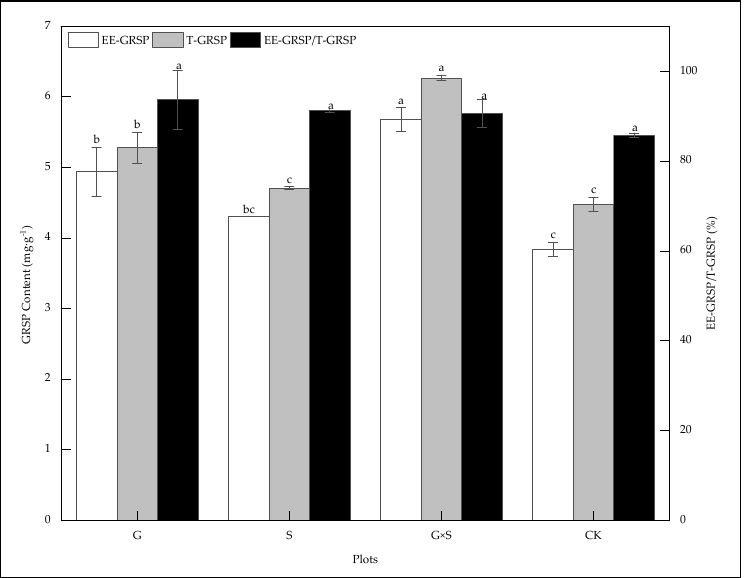
Figure 1. Distribution characteristics of EE-GRSP and T-GRSP of rhizosphere soil among different vegetation types. Different lowercase letters indicate significant differences between plots ( p < 0.05).